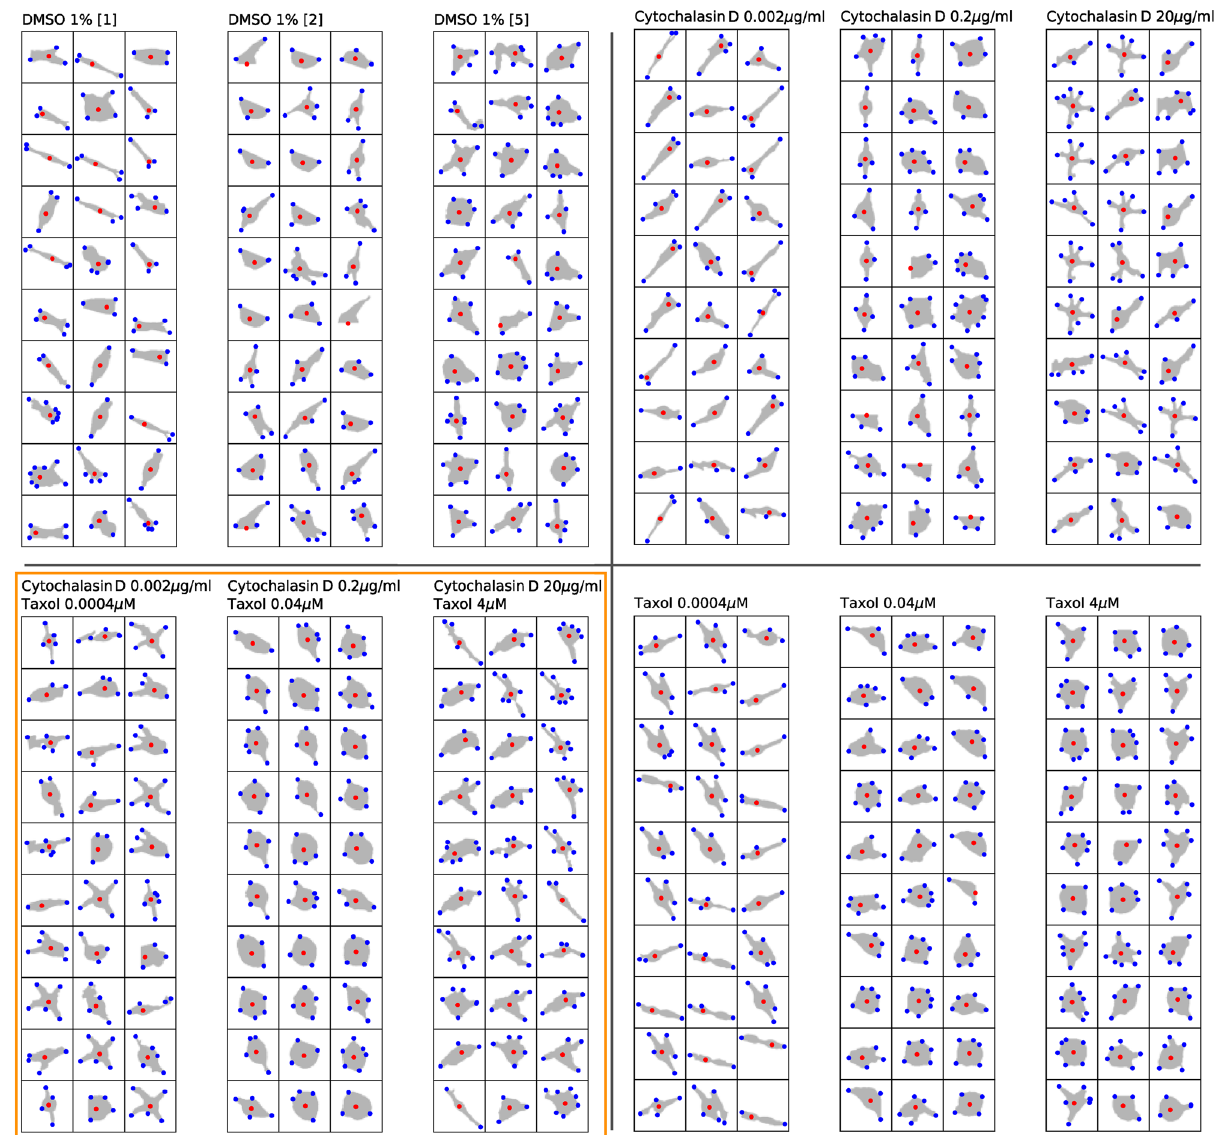
Figure 14. Random ensemble of cell morphologies with cell vertex (red) and cell protrusions (blue) for a variety of concentrations of cytochalasin D and taxol as well as the control